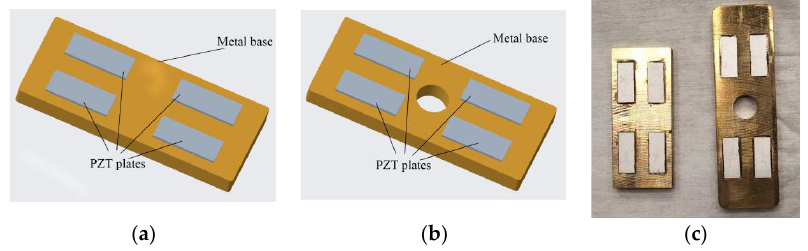
Figure 1. Three-dimensional structure of the vibrators: ( a ) The standing wave vibrator; ( b ) The traveling wave vibrator; ( c ) Prototype vibrators.